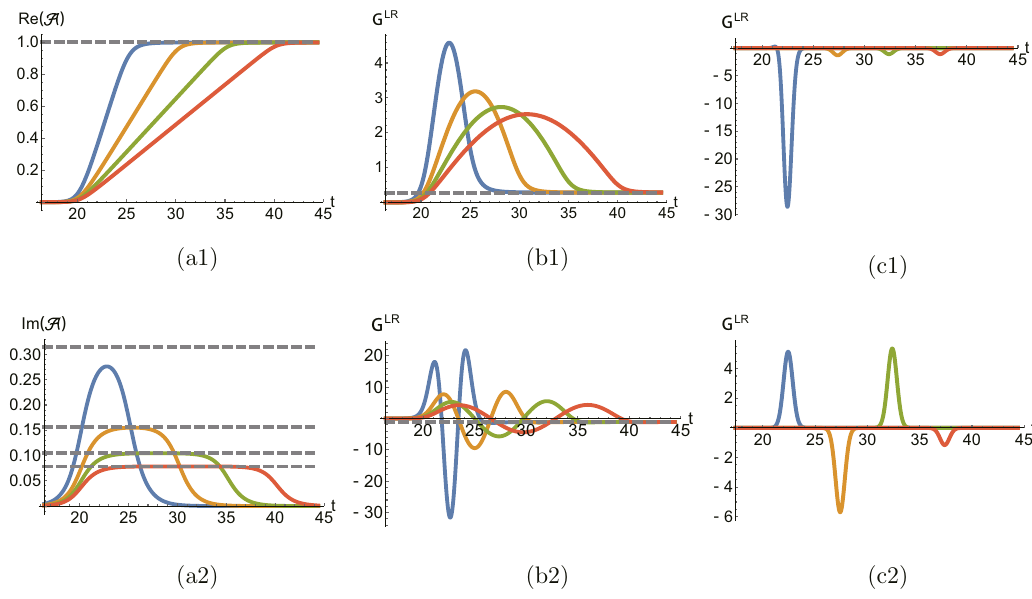
Figure 6 . Plots of A and G LR in various cases. We take h O = 4 = 9, (cid:12) = 2 (cid:25) , (cid:1) J = 2 h J = 10, x = x s = 0, h J =c = 10 (cid:0) 10 . Plots (a1) and (a2) are respectively real and imaginary parts of A ( t ) with g e(cid:11) = 3. Blue, yellow, green, red curves are for L= 2 = 5 ; 10 ; 15 ; 20 respectively, and the gray dashed lines are (cid:12)= (2 L ) = (cid:25)=L . Plots (b1) and (b2) are respectively G LR ( t; t s = t ) with g e(cid:11) = 3 and g e(cid:11) = 10. Blue, yellow, green, red curves are for L= 2 = 5 ; 10 ; 15 ; 20 and gray lines are asymptotic values 2 sin( g e(cid:11) ) for large t . In (c1) and (c2) we plot G LR ( t; t s ) as a function of t for di(cid:11)erent t s , with g e(cid:11) = 10. For (c1) L= 2 = 5 and for (c2) L= 2 = 15. Blue, yellow, green and red curves are for t s = t (cid:3) + 3 ; t (cid:3) + 8 ; t (cid:3) + 13 ; t (cid:3) + 18